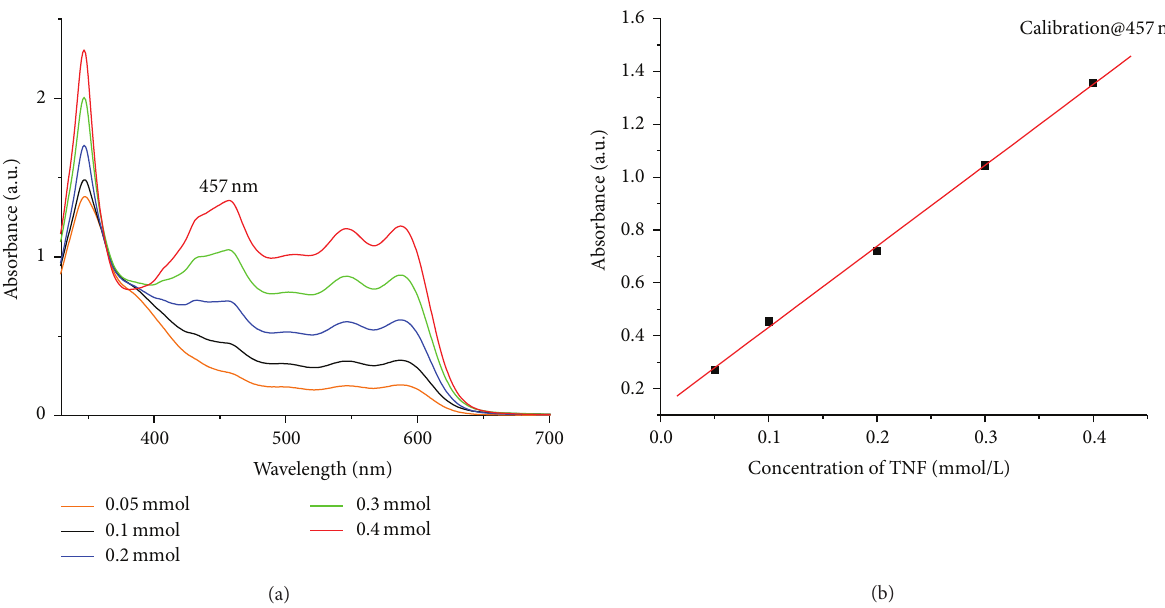
Figure 9: (a) Absorbance of TFN at different concentrations in acetonitrile as complex with DDQ (DDQ concentration was maintained constant: 22 mM for all samples) and (b) calibration graphs derived from (a) according to Beer-Lambert law.